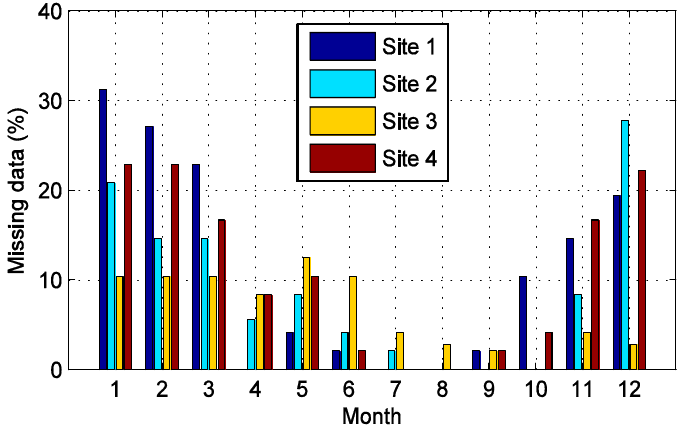
Figure 7. Monthly distribution of the gaps for the four sites considered.